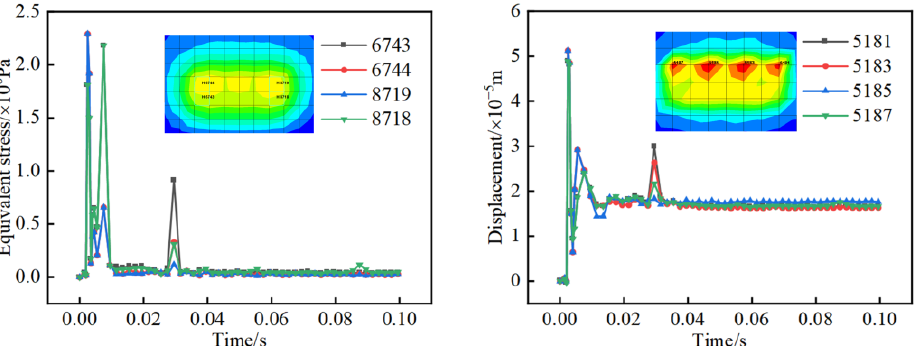
Figure 8. Time – history curves of equivalent stresses ( left ) and X -displacements ( right ) at different positions.